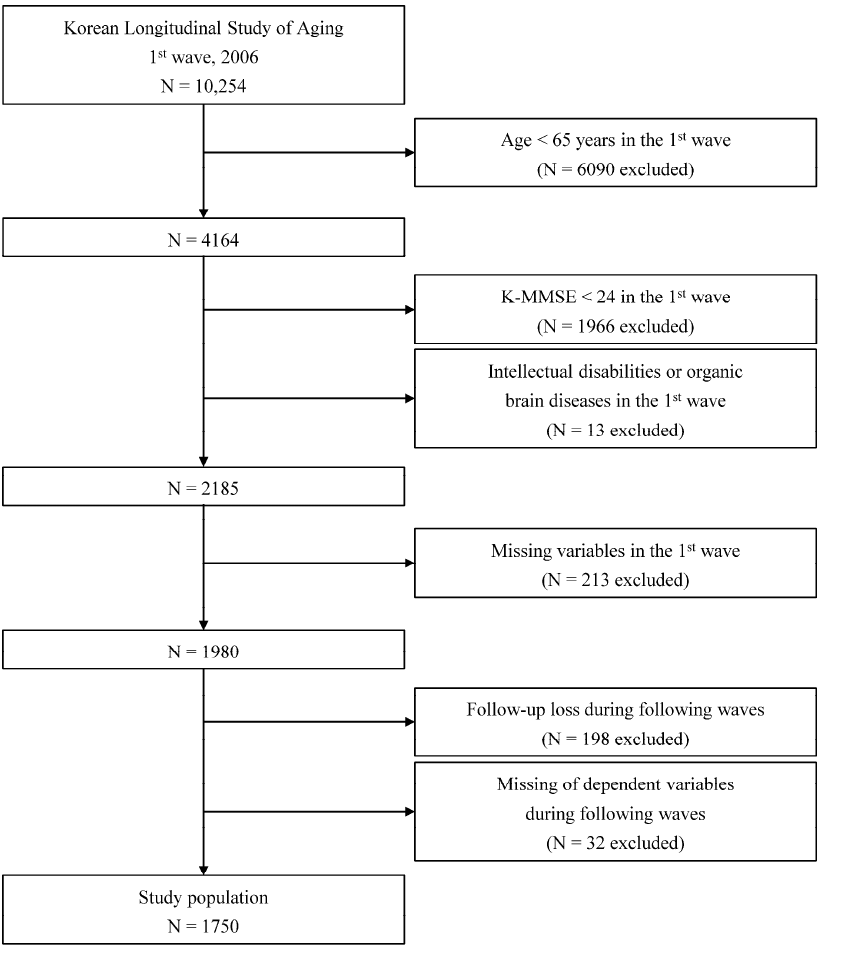
Figure 1. Process for selecting the study